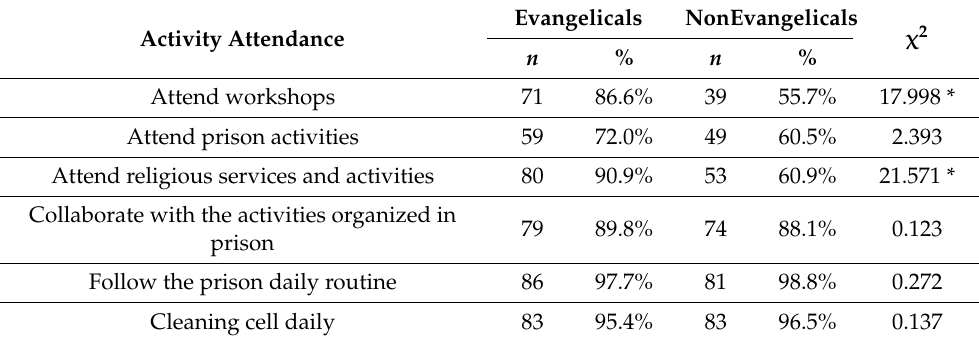
Table 1. Activity attendance in prison.